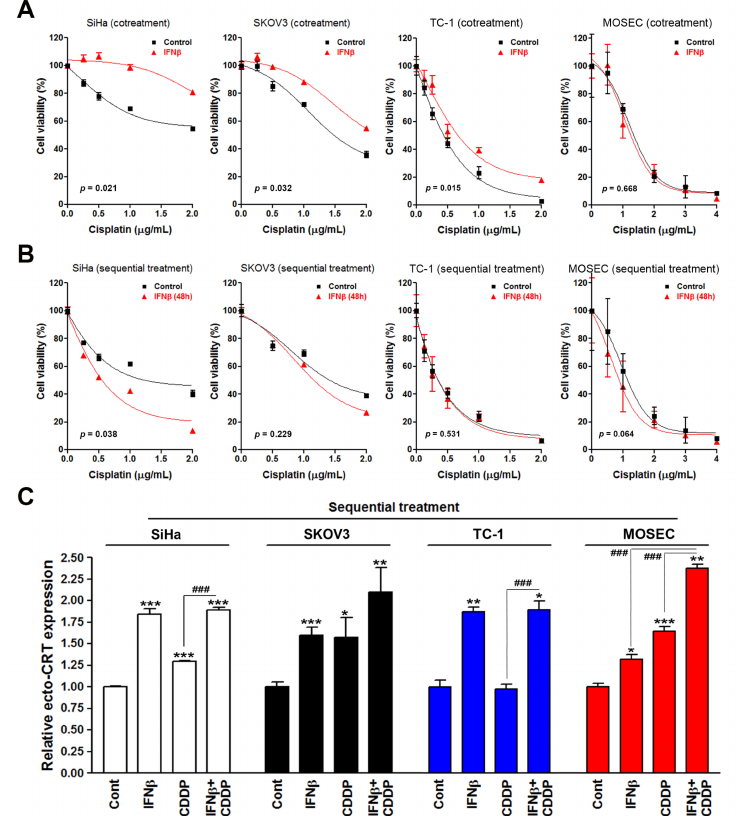
Figure 2. E ff ects of interferon β (IFN β ) and cisplatin treatment protocols on cell viability and surface calreticulin expression in cancer cells. ( A ) SiHa, SKOV3, TC-1, and MOSEC cells were cotreated with 100 ng / mL IFN β and the indicated doses of cisplatin for 72 h. Cell viability was examined by MTT assay. ( B ) SiHa, SKOV3, TC-1, and MOSEC cells were treated with 100 ng / mL IFN β for 48 h, and then cells were replated in 96-well plates and treated with the indicated doses of cisplatin for 72 h. Cell viability was examined by MTT assay. ( C ) SiHa, SKOV3, TC-1, and MOSEC cells were sequentially treated with 100 ng / mL IFN β for 24 h and 2 µ g / mL cisplatin for another 24 h. Surface CRT (ecto-CRT) staining was performed and analyzed by flow cytometry. The mean fluorescence of ecto-CRT was quantified and plotted. p < 0.05 (*), p < 0.01 (**) and p < 0.001 (*** or ### ) indicate significant di ff erences compared to control samples or the indicated